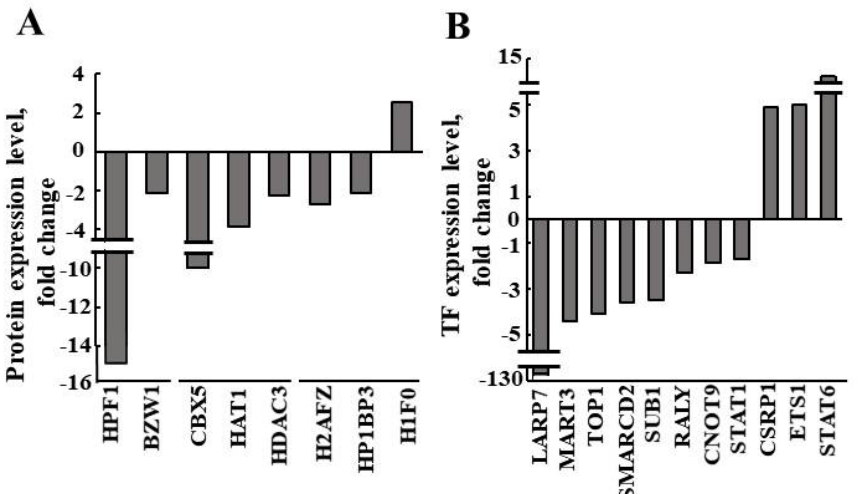
Figure 5. Epigenetics-related proteins differentially expressed in si-NT-TTs and si-hVDAC1-TTs revealed by LC-HR MS/MS analysis. ( A , B) Quantitative analysis of proteins differentially expressed in si-VDAC1-TTs, in comparison to si-NT-TTs, using LC-HR MS/MS data and presented as fold change protein expression level. Up- or down-regulated histone-associated proteins ( A ) and transcription factors ( B ), with p -values presented in Tables 3 and 4, respectively.